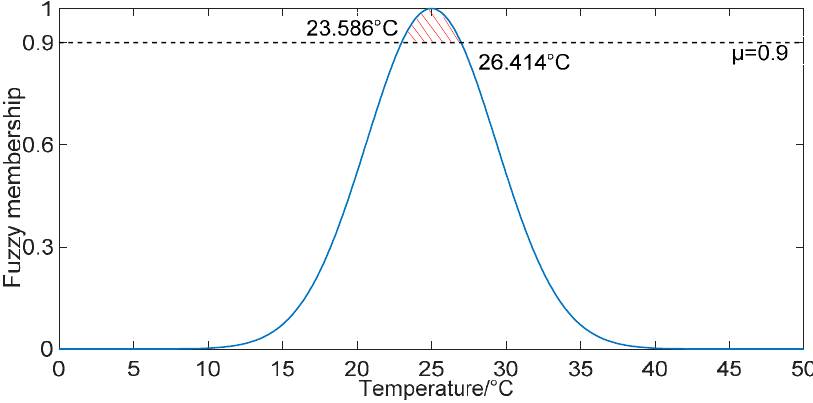
Figure 1. Fuzzy membership function based on users’ thermal comfort.